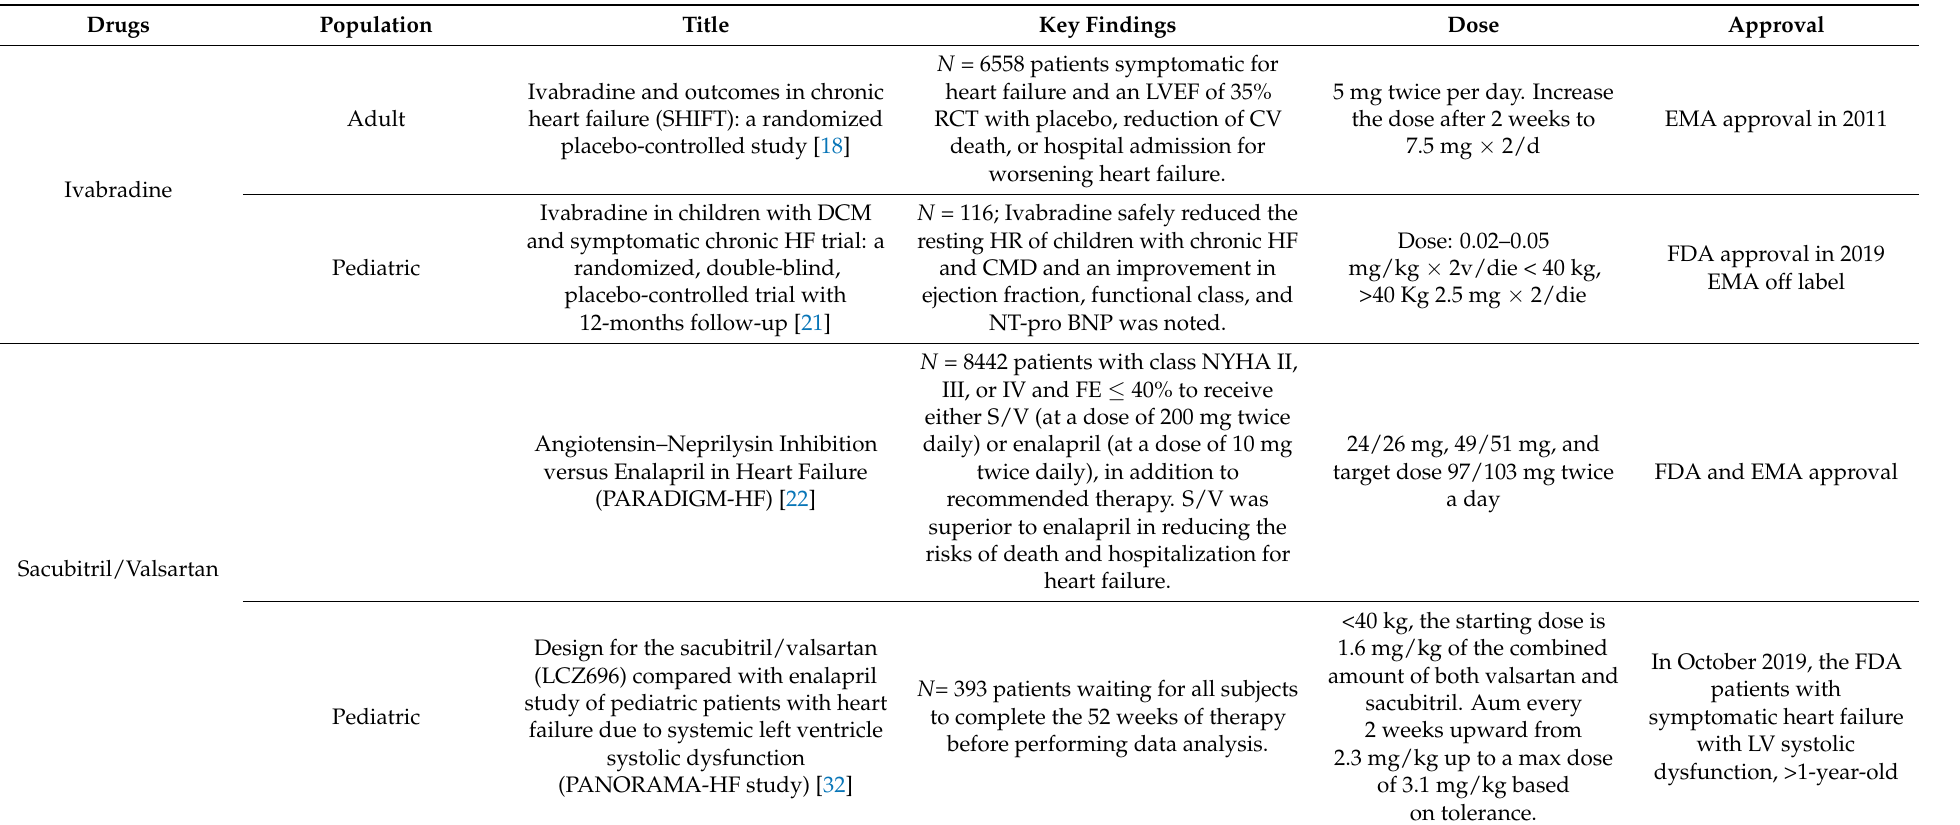
Table 3. Summary of the clinical trials on new drugs for HF in pediatric and adult